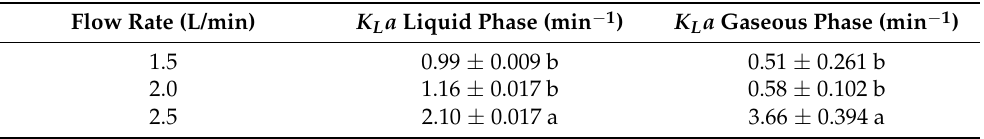
Table 1. Bioreactor gas transfer in liquid and gaseous